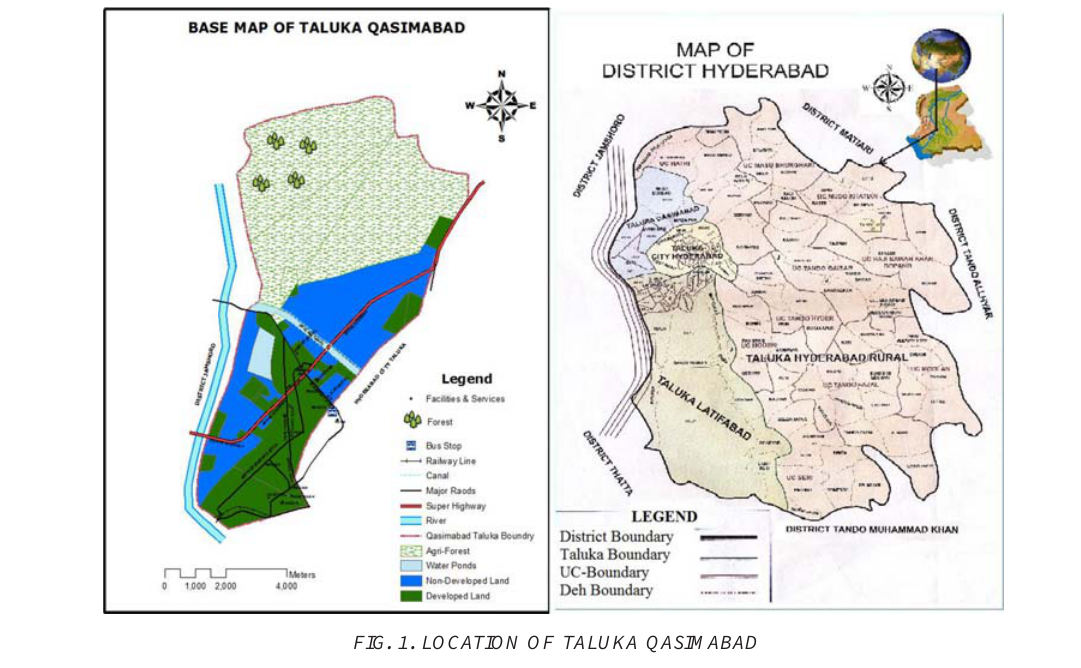
FIG. 1. LOCATION OF TALUKA